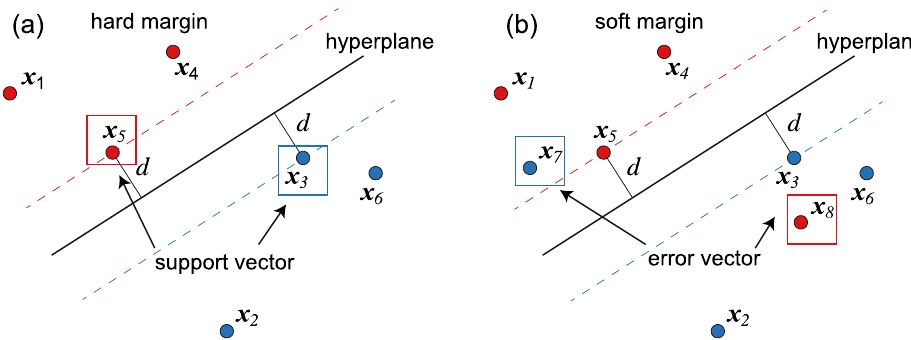
Figure 4. Illustration of the hyperplane and the support vector. Two support vectors are marked by red and blue squares. ( a ) Hard margin where red and blue points are separated perfectly, and ( b ) soft margin where they are separated